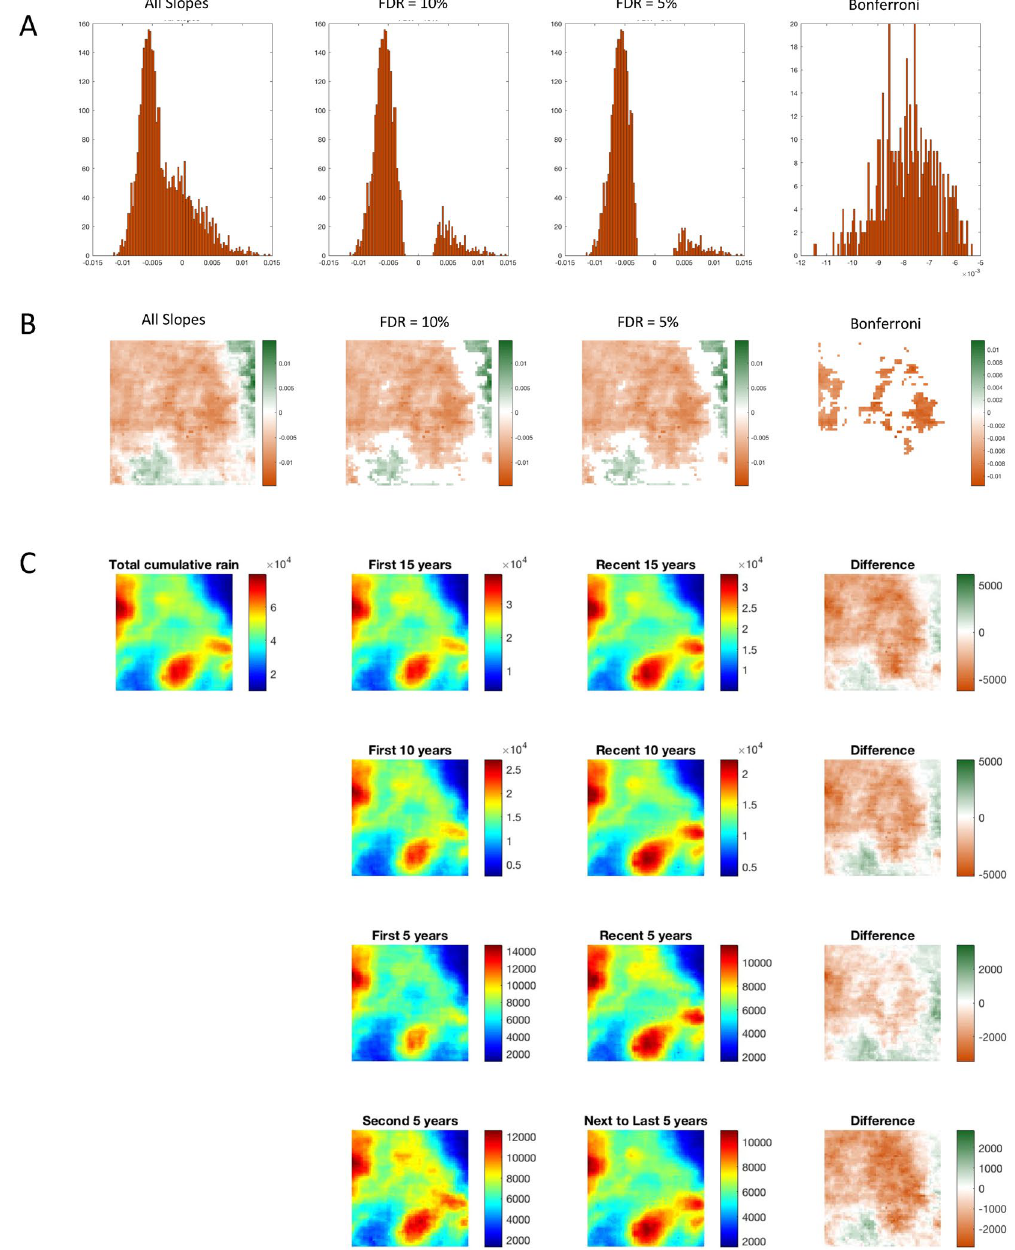
Figure 3. The decrease in rainfall is a robust finding. We first performed an exploration of false discovery rates, and then independently tested with cumulative rainfall differences. ( A ) Histogram of the 3,721 GLM slopes from Fig. 2E. With progressively more conservative FDR rates, we see the progressive elimination of small magnitude slopes, culminating in the most conservative thresholding with Bonferroni ( α /3721). In ( B ) we map these distributions of slopes back onto the satellite grid. Note that the most significant slopes retain the coherent regions of central and western Uganda where the rainfall decreases the most over the historical record. To independently test these findings, we examine the difference maps of cumulative rainfall from the raw ARC2 data in ( C ). Indeed, for the first and most recent 15, 10, and 5 year cumulative data, and the second and second-to-last 5 year periods, the difference maps retain the same rainfall pattern of decrease indicated from the GLM fits. Maps created using ArcGIS 10.4.1, http://support.esri.com/Products/Desktop/ArcGIS-desktop/